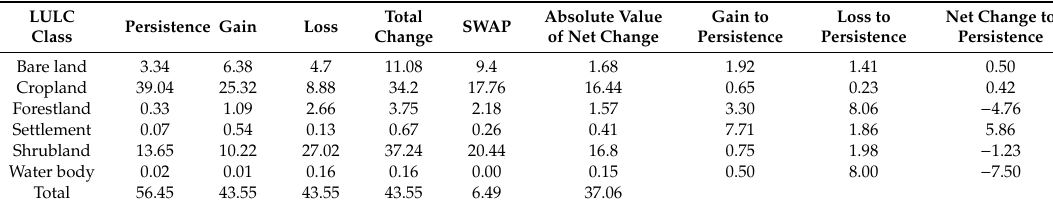
Table 6. LULCCs in the period 2000–2018 in